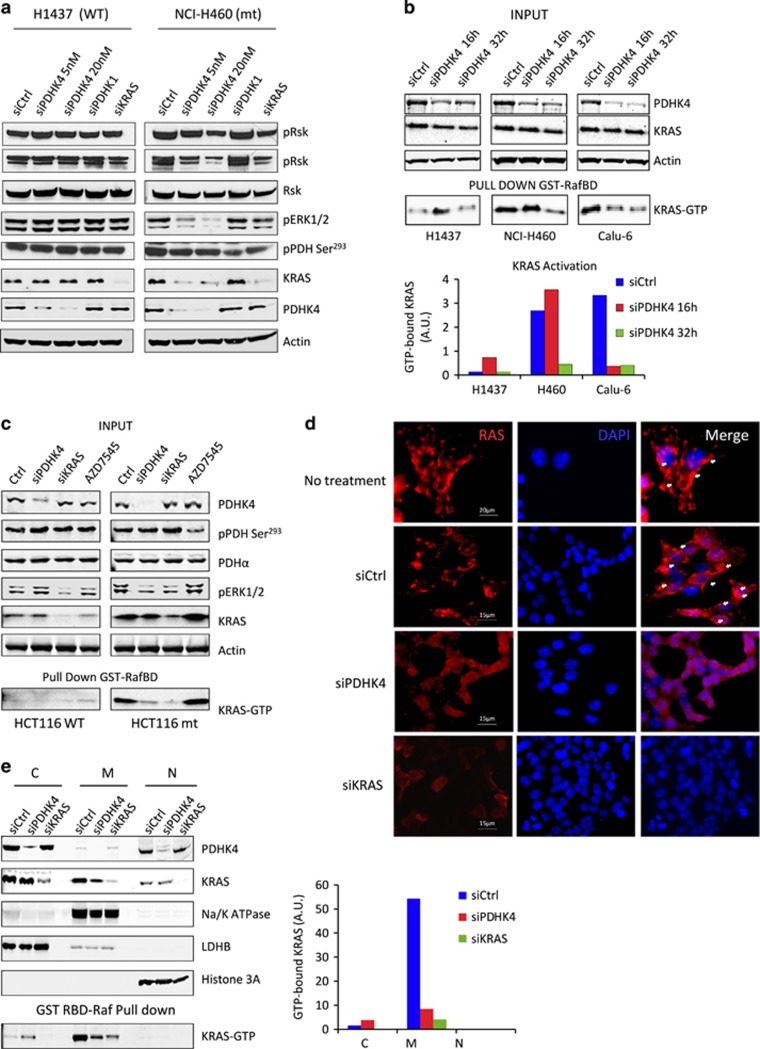
PDHK4 is essential to maintain KRAS signalling pathway, activity and cellular localization. (a) NCI-H1437 and NCI-H460 cells were treated with PDHK4 (5 and 20 nM), PDHK1 (10 nM) and KRAS (10 nM) siRNA for 72 h and RAS signalling pathway activation was assessed by western blotting using phospho-specific antibodies as indicated. (b) RAS activity was measured using RAF1-RBD-RAS GTP-specific pull-down assay using GST-tag beads after PDHK4 knockdown treatment at 16 and 32 h. Graph represents the quantification of GTP-bound KRAS pool related to KRAS total expression levels. (c) Isogenic HCT116 cells were treated for 48 h with PDHK4 and KRAS siRNAs (10 nM) and 5 μM of AZD7545 (PDHK1/2 inhibitor). Lysates were subjected to the same KRAS GTPase-specific pull-down assays in (b) and total proteins were detected by the indicated antibodies following western blot analysis. (d) HCT116 cells were fixed in paraformaldehyde 4%, blocked and stained with Pan-RAS antibody (Red) and nuclear counter-stain 4',6-diamidino-2-phenylindole (blue) after 48 h of PDHK4 and KRAS knockdown (10 nM siRNA). White arrows correspond to specific compartment localization of RAS staining. (e) Cell fractionation was performed in HCT116 cells after 48 h of PDHK4 and KRAS knockdown. Each fraction was subjected to immuno-blotting and KRAS GTPase-specific pull-down assay. Chart represents the quantification of GTP-bound KRAS in the cytoplasmic, membrane and nuclear fractions normalized to LDHB, Na/K ATPase and Histone 3A levels respectively.